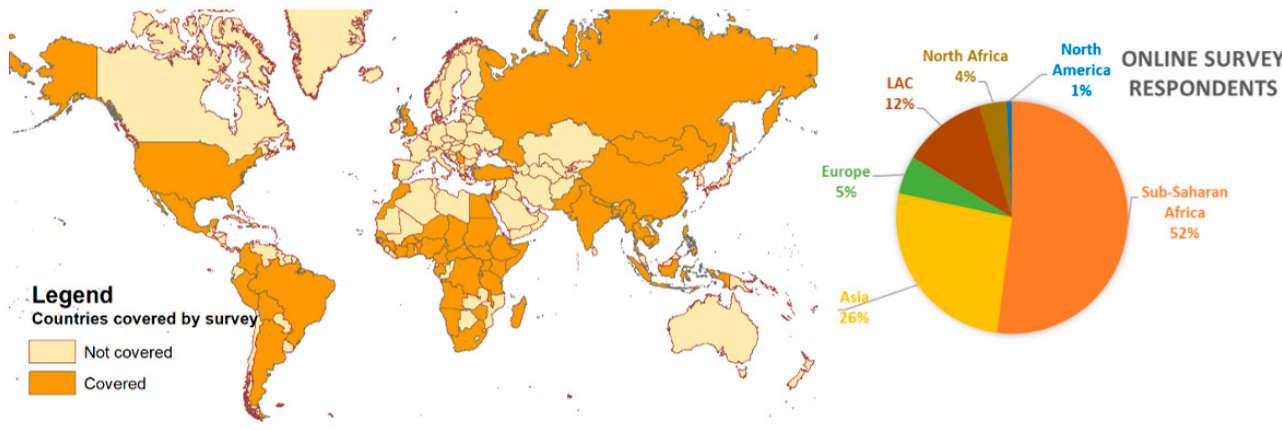
Figure 4. Geographic coverage (users working with deprived areas data) ( left ) and geographic distribution of online survey respondents in percentage ( right ).